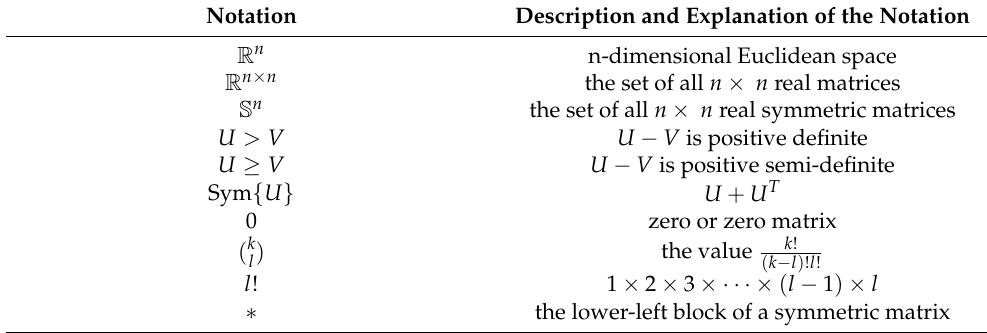
Table 1. The notations and their explanations throughout the